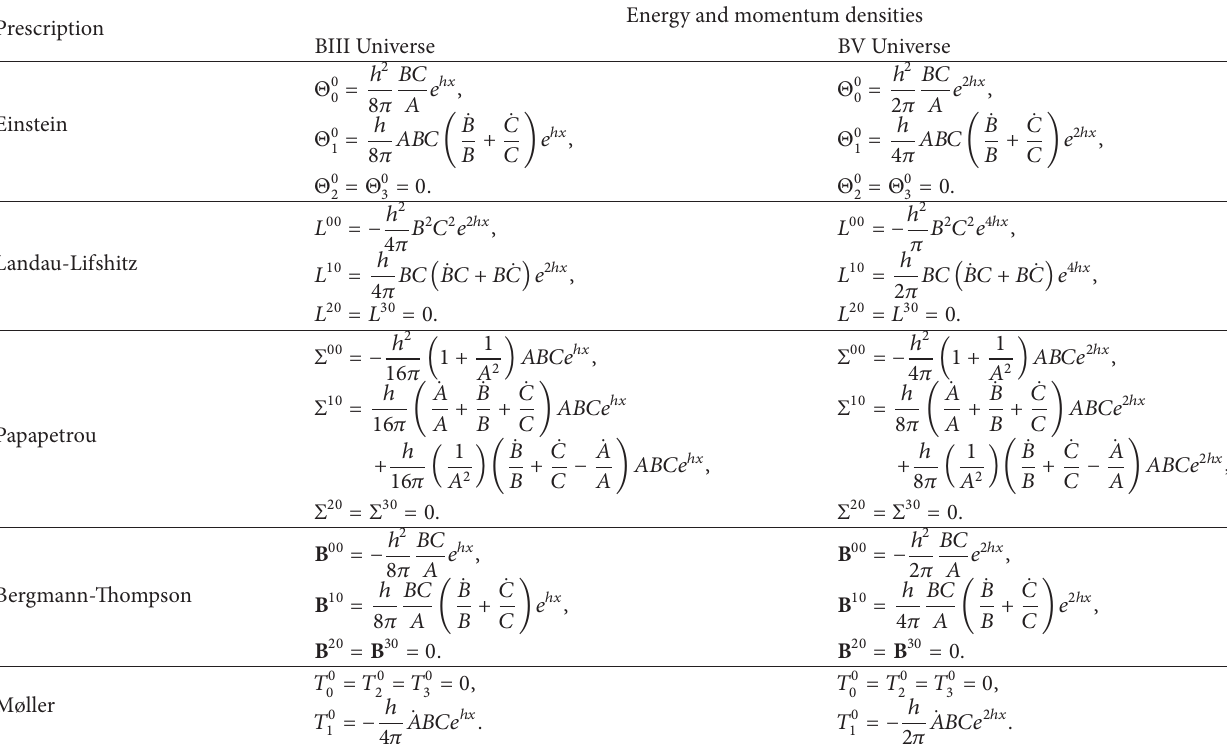
Table 4: Energy and momentum densities for BIII and BV